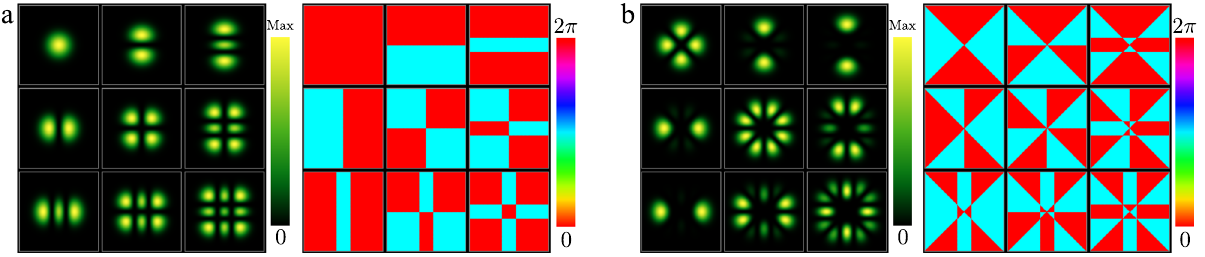
Fig. 4 Propagation of Hermite-Gaussian modes in a weak gravitational fi eld. Hermite-Gaussian mode HG m , n ( x + , x 1 , x 2 ) is not shape invariant under propagation in the Schwarzschild spacetime geometry, and both the intensity and phase pro fi les modify. a Intensity and phase distributions of the fi rst 9 HG modes m , n ∈ {0, 1, 2} prior to the free-space propagation. b The intensity ∣ εψ (1) ∣ 2 and phase arg εψ ð 1 Þ distributions of the corrected term, for the fi rst 9 HG modes m , n ∈ {0, 1, 2}, after the propagation in a weak gravitational fi eld. The rows and columns are associated to m ∈ {0, 1, 2} and n ∈ {0, 1, 2}, respectively. The dimensionless coordinates are used for these